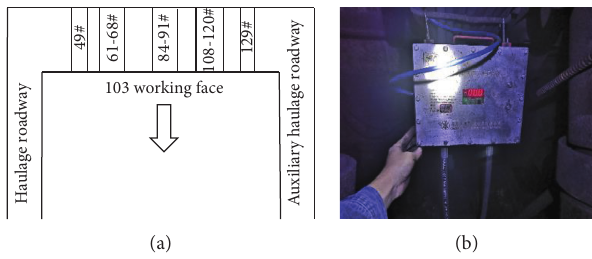
Figure 4: (a) Layout of monitoring stations for working resistance of support. (b) On-site monitoring.